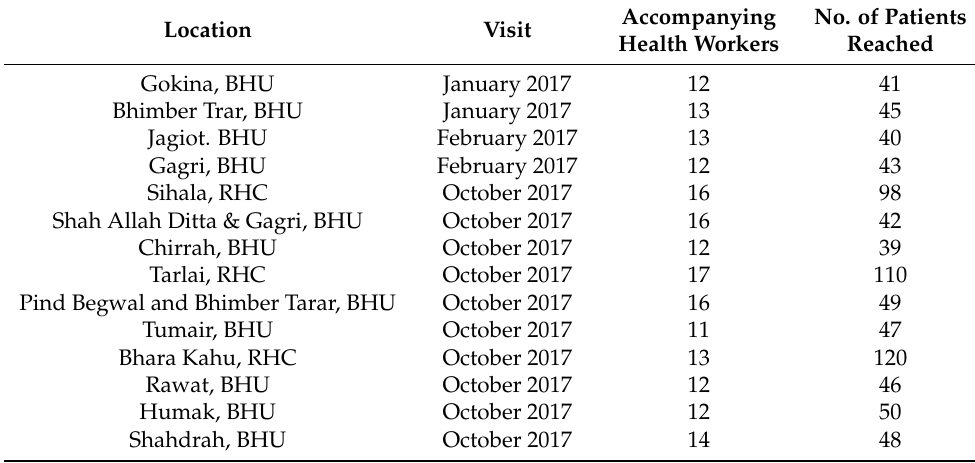
Table 4. The activities carried out in rural Islamabad in 2017.